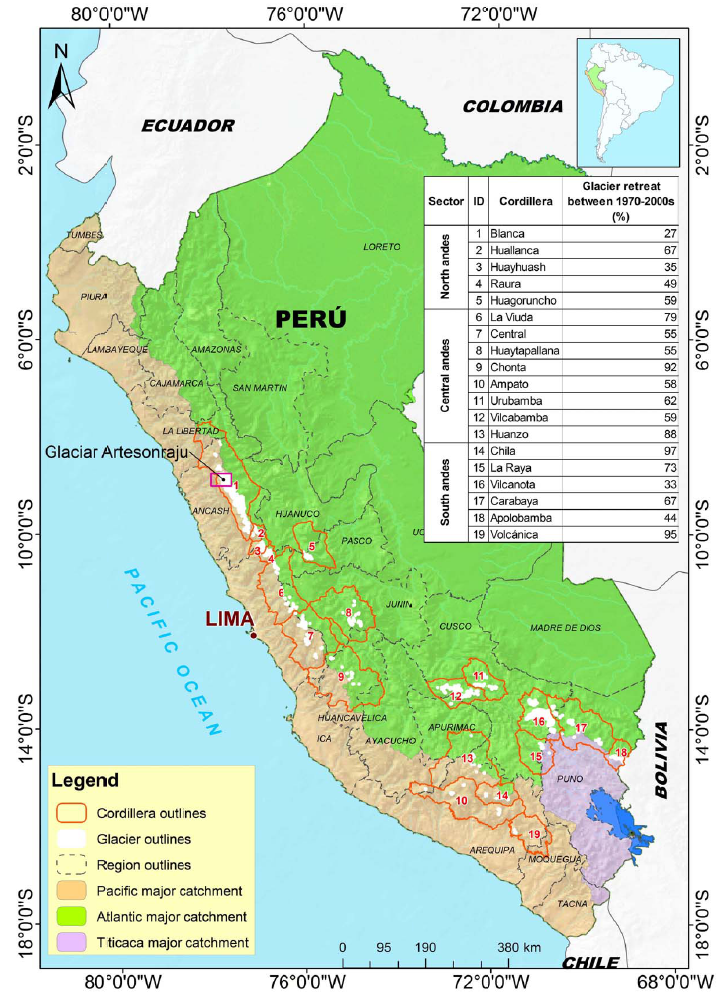
Figure 2. Study area with the glacier-covered Cordilleras of Peru in South America, between 7 ◦ 32 (cid:48) 1 (cid:48)(cid:48) –16 ◦ 48 (cid:48) 52 (cid:48)(cid:48) south and 68 ◦ 56 (cid:48) 54 (cid:48)(cid:48) –78 ◦ 27 (cid:48) 25 (cid:48)(cid:48) west, situated in the Northern, Central and Southern Andes, hydrologically located in the Pacific, Atlantic, and Titicaca